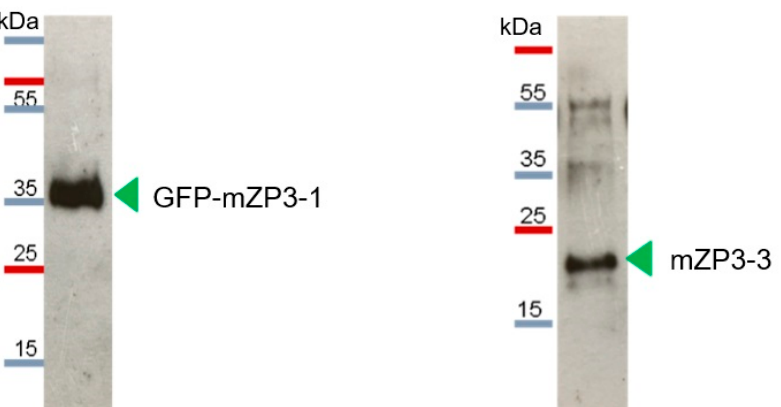
Figure 3. Profile of lectin binding to the N. benthamiana -expressed proteins to detect the presence of sugar residues on proteins. The profile represents the binding of Con A to the recombinant GFP- mZP3-1 ( left ) and mZP3-3 ( right ). Lectin blot labeled with peroxidase-conjugated concanavalin A. Blots cropped for clarity, for uncropped blots see Figure S4.